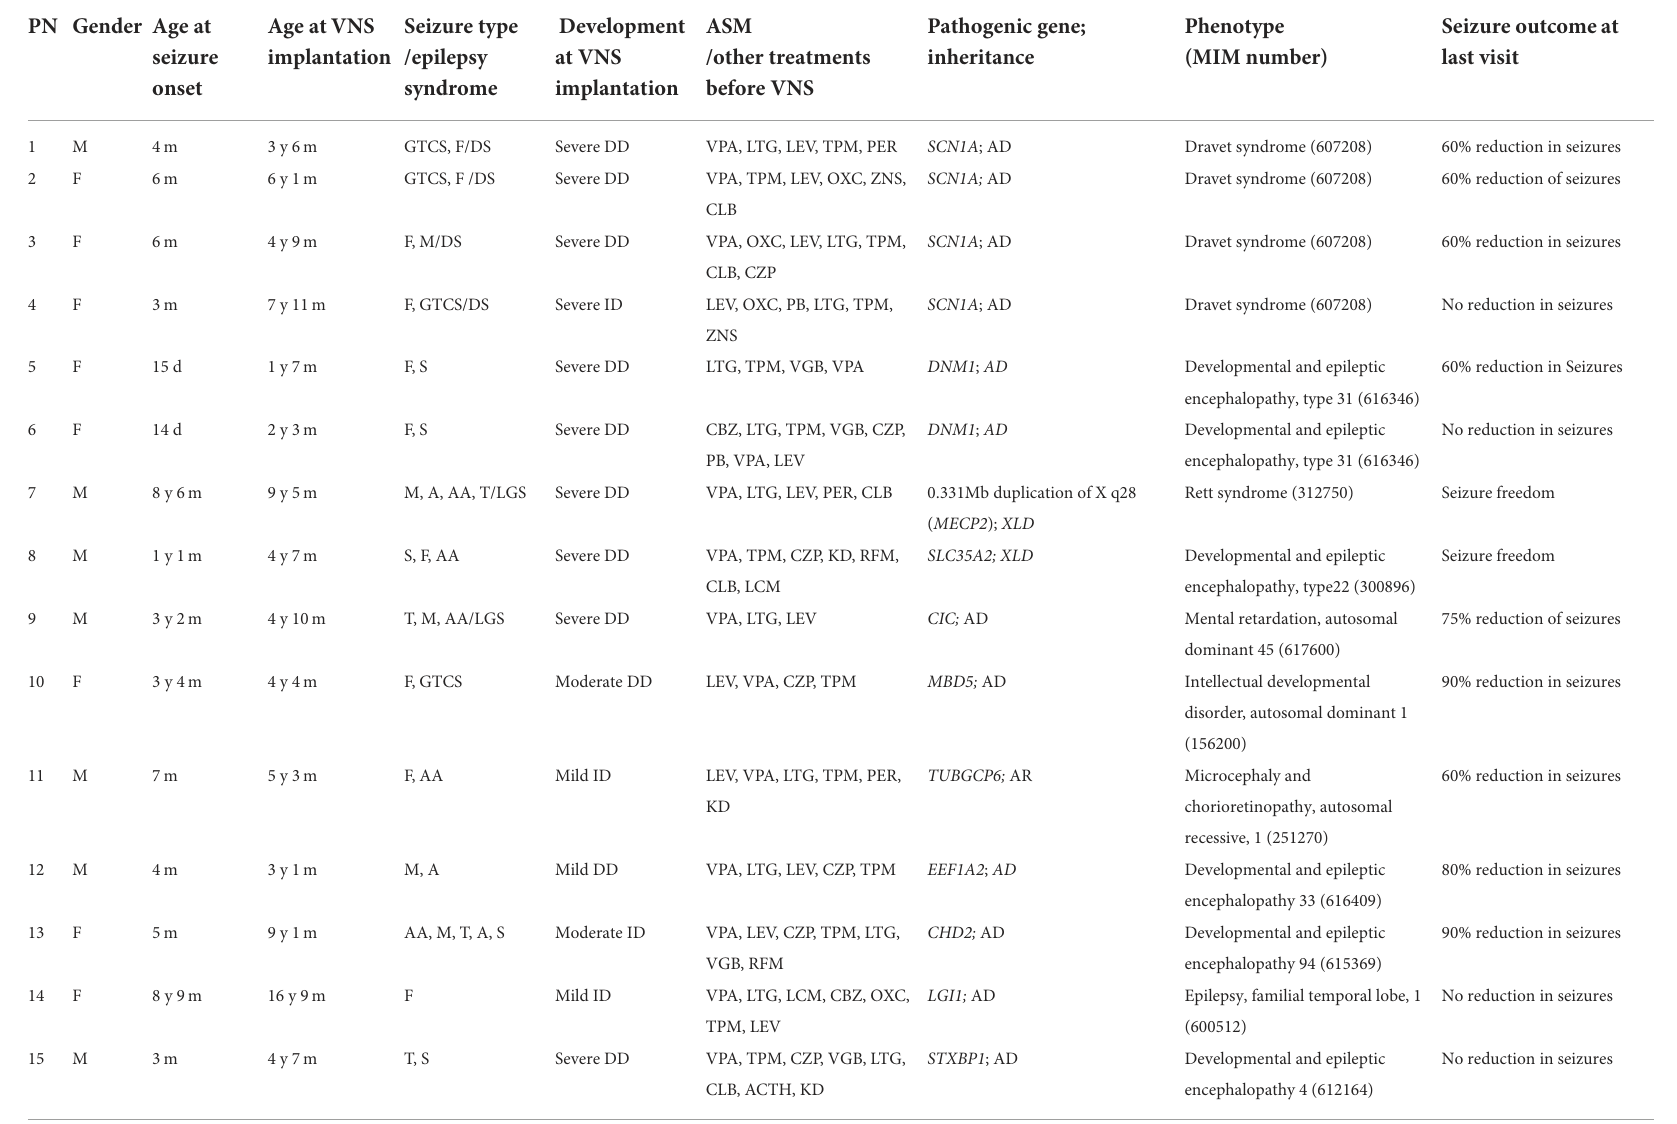
TABLE 1 Clinical and genetic information of the 20 children with monogenic etiologies of DRE. PN Gender Age